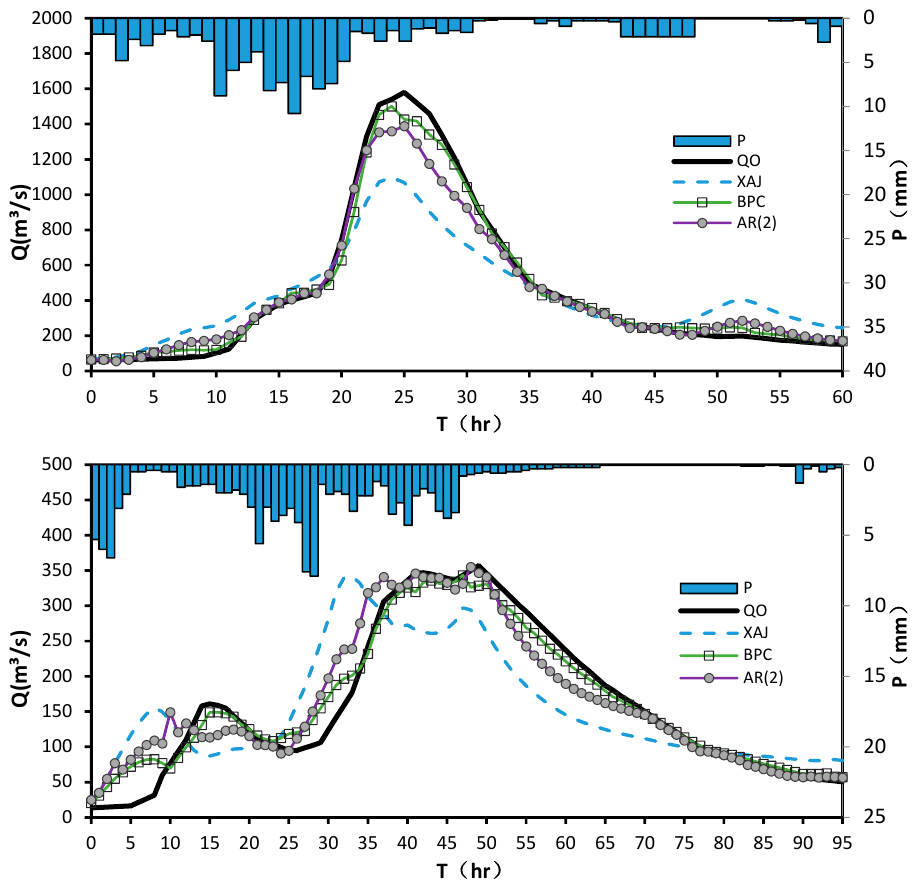
Figure 6. Real ‐ time correction performance comparison of BPC and AR(2) of floods 20011021 and 20020817. Table 5. Comparison between original model results and real ‐ time correction results of BPC and AR(2). Flood Code Flood